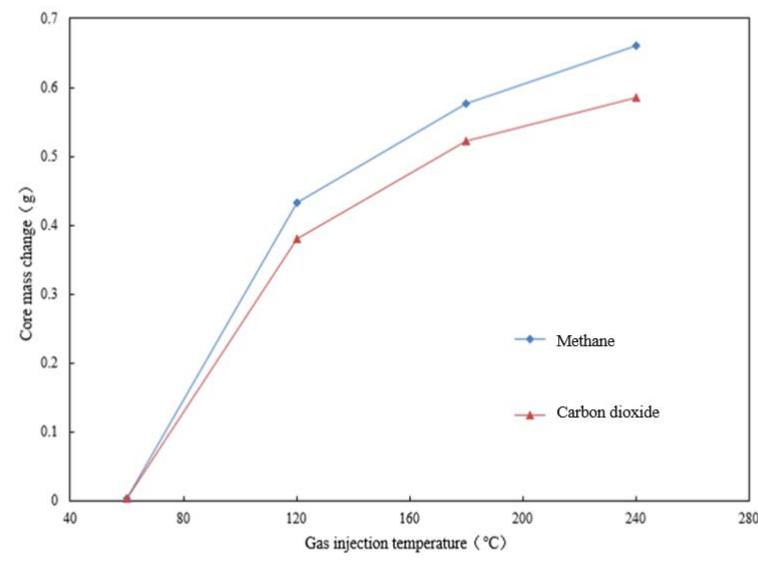
Figure 2. Relationship between gas-injection temperature and core mass change.